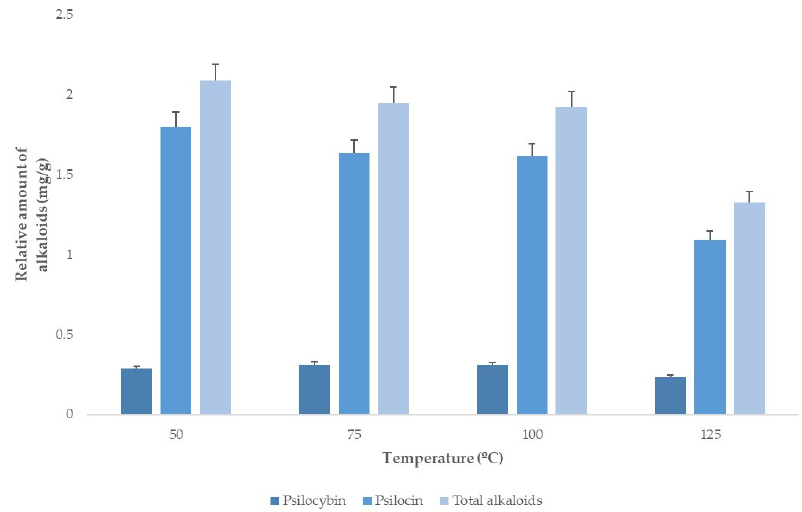
Figure 3. Alkaloids extraction yields at different temperatures ( n = 2).